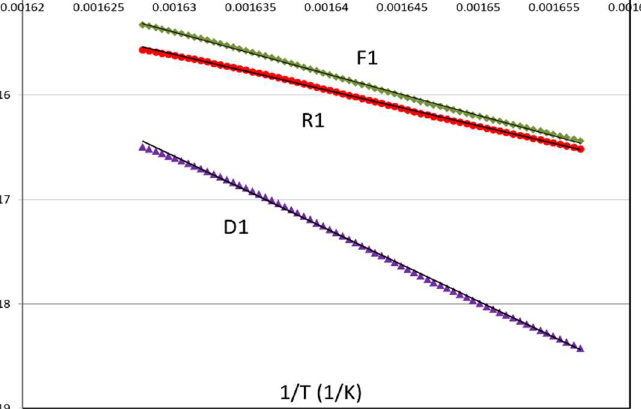
Figure 4. Application of the general analytical equation by linear regression for the thermal decom- position of the bioblend containing 70% of PLA treated by reactive extrusion (PLA REX /PA 70/30), with a nominal heating rate of 10 K/min. Note: y axis is the first member of the general analytical equation in linear form shown in Table 3 for each mechanism.